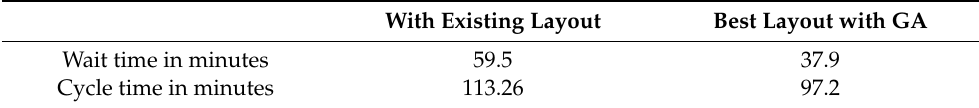
Table 4. Comparison of wait time and cycle time in existing layout and optimized layout. With Existing Layout Best Layout with GA Wait time in minutes 59.5 37.9 Cycle time in minutes 113.26